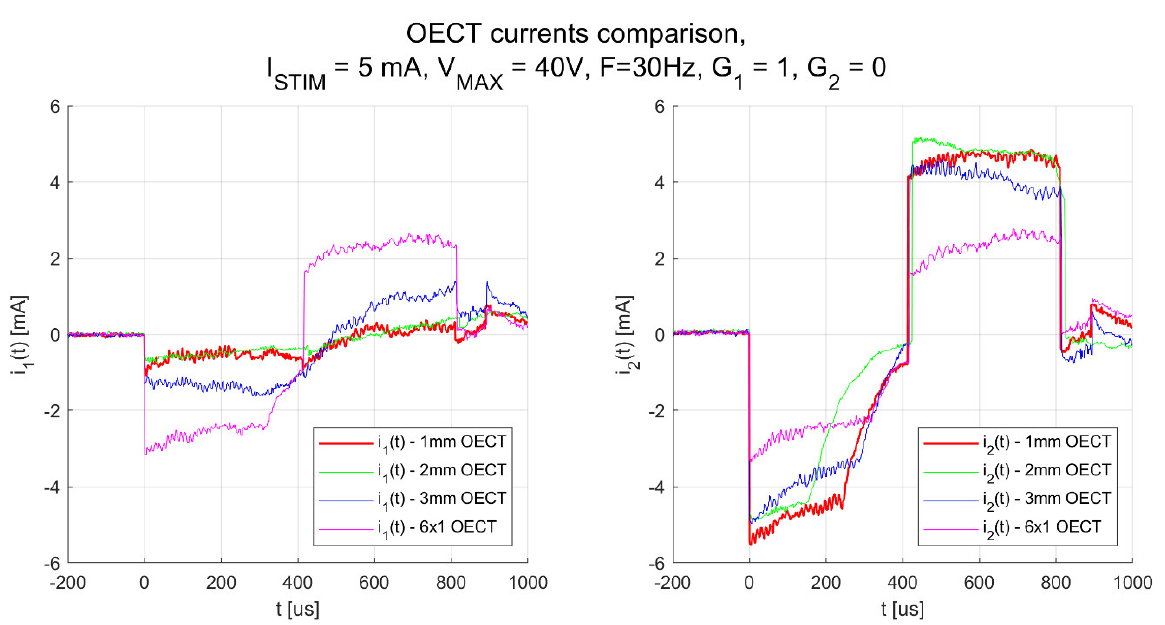
Figure 7. Current throughput vs. time for various OECT channel widths. The current was measured in the two parallel branches of the OECT characterization testbed for four different OECT architectures: 1 mm, 2 mm and 3 mm channel widths and the 6 × 1 mm interdigitated design. The branch with an OECT switched to its non-conductive state is shown in the left panel, and the branch with an OECT in its conductive state is shown in the right panel. The plots show the corresponding